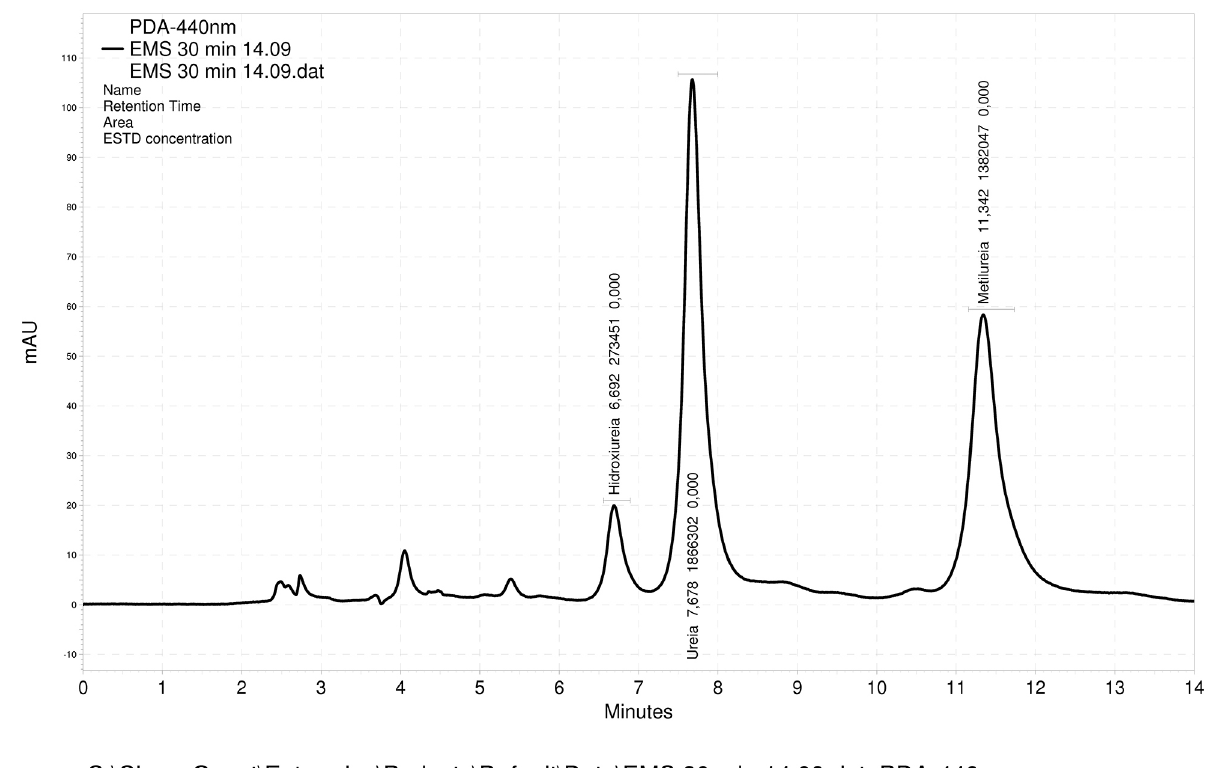
FIGURE 2 - Chromatogram of plasma from patients undergoing SCA therapy with hydroxyurea 1000 mg/day enriched with 15.5 mM methylurea (internal standard).